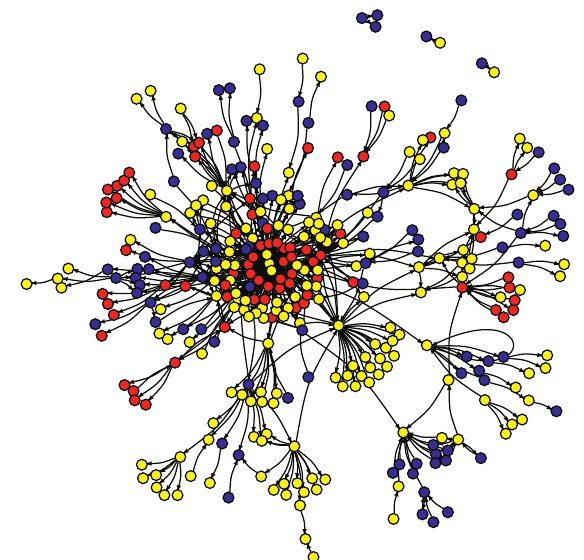
Figure 3: The Tianjin Port blast response network by jurisdiction. Red � local, yellow � provincial, blue � national.